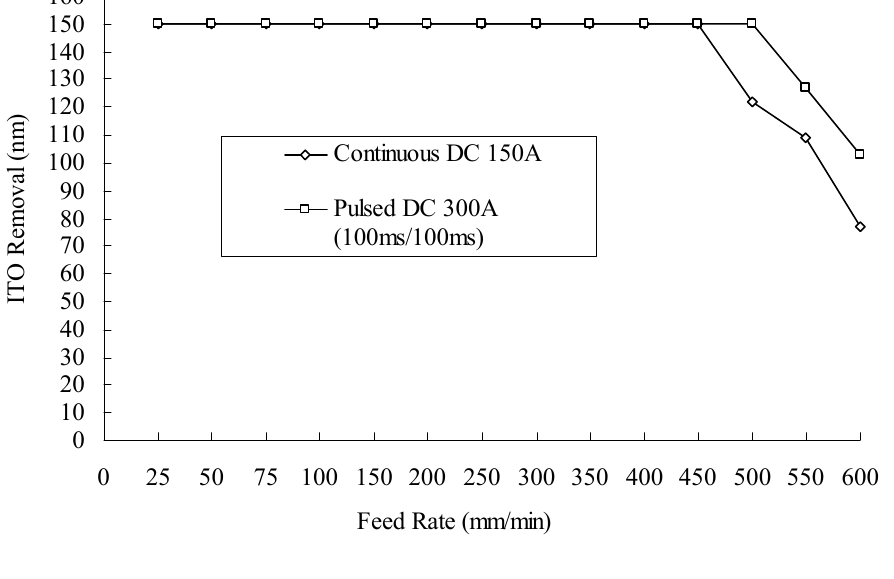
Figure 7. Amount removed at different feed rates of the workpiece using continuous and of 10 wt% and PO4-3-P 5 wt%, 55 °C, 150 A, pulsed direct current (NaNO 3 negative-electrode 300